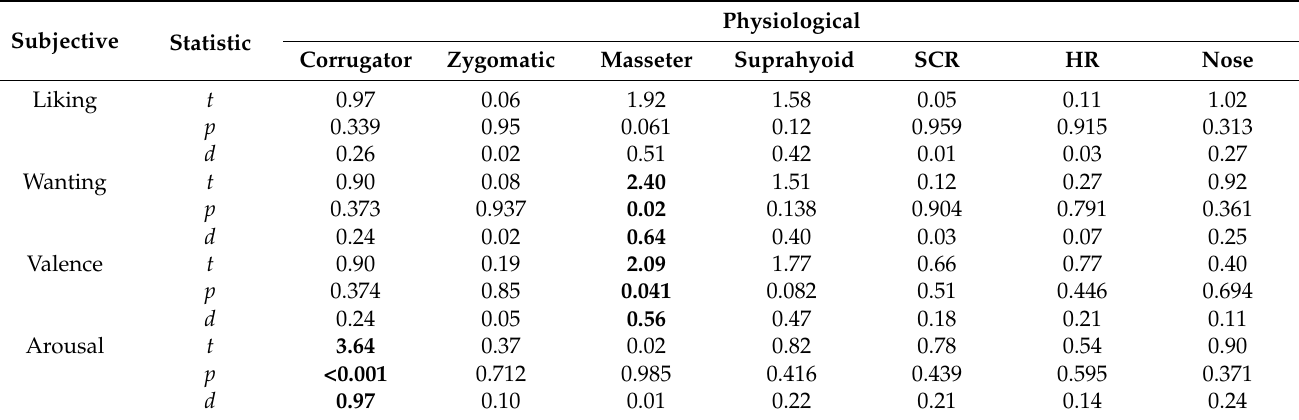
Table 2. Results of the independent t -tests (young vs. older adults; two-tailed) for subjective- physiological